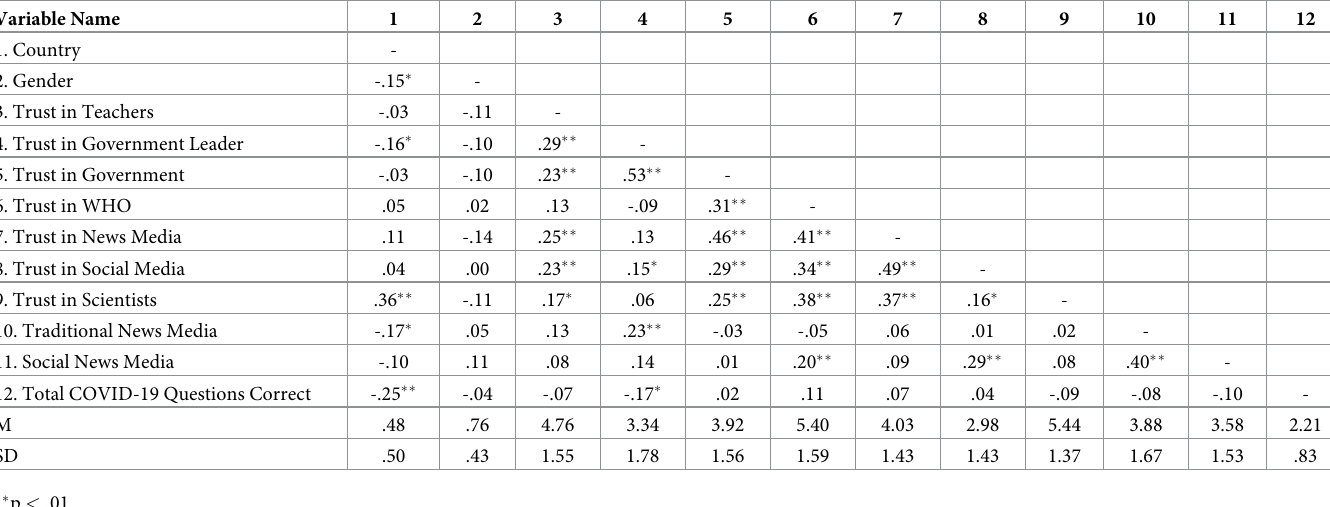
Table 1. Means, standard deviations, and bivariate correlations for study